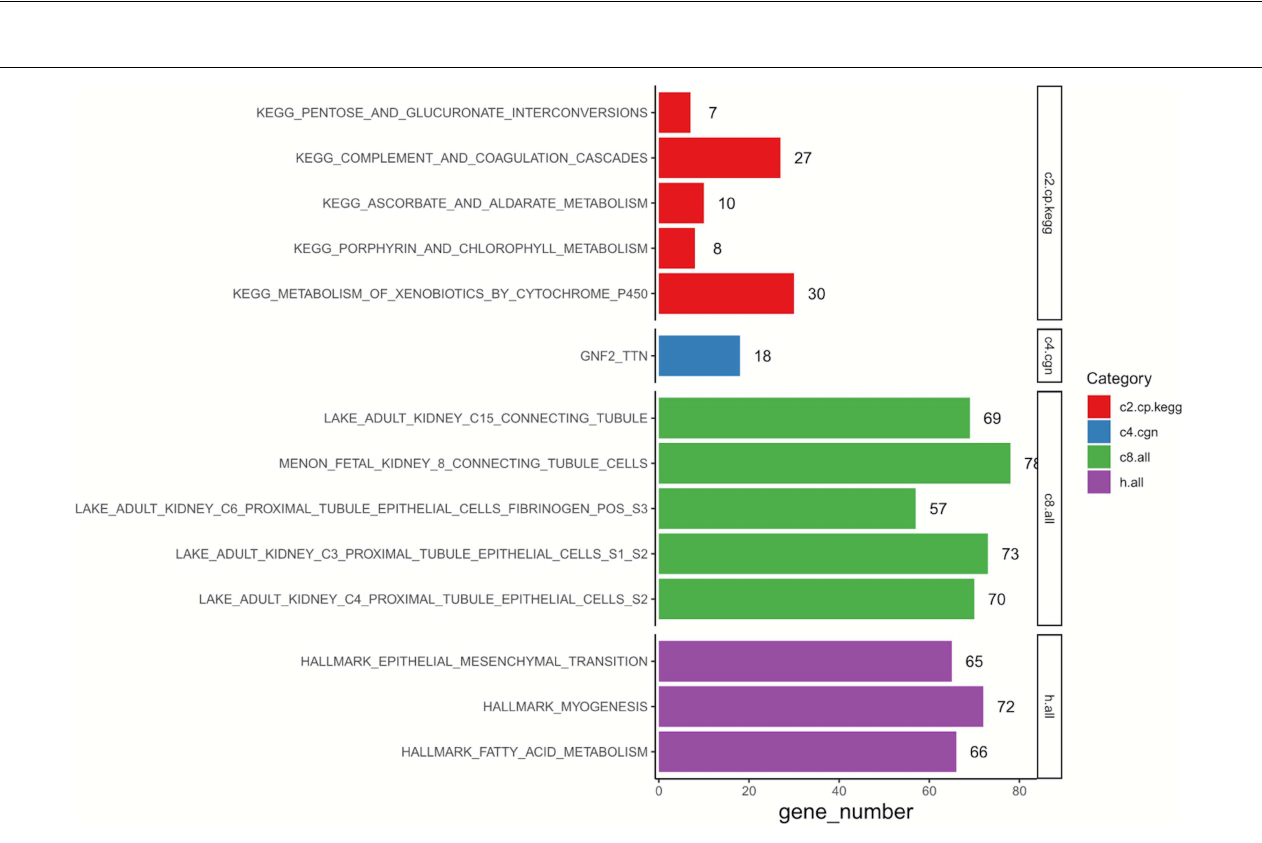
FIGURE 2 | Results of GSEA on 760 DEGs. C2, curated gene sets; C4, computational gene sets; C8, cell type signature gene sets; Hallmark, hallmark gene sets; GSEA, gene set enrichment analysis; DEGs, differentially expressed genes; KEGG, Kyoto Encyclopedia of Genes and Genomes.